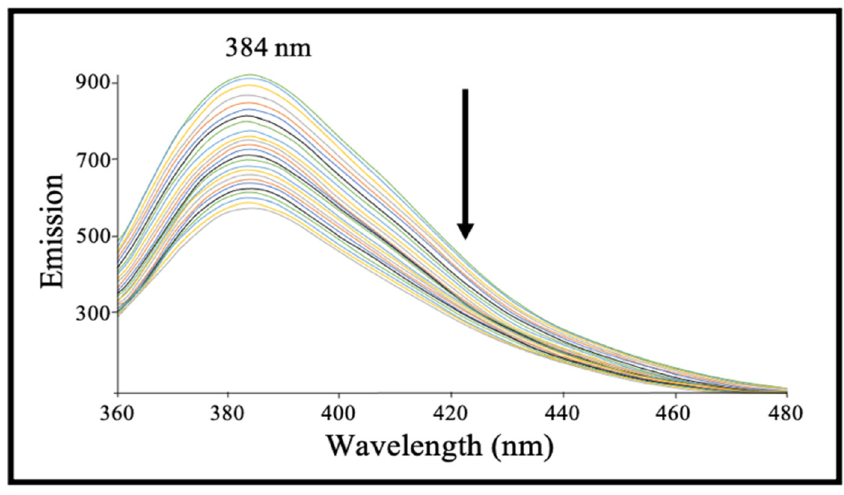
Figure 4. Fluorimetric titration spectra of [Cu(CQ)(PPh 3 ) 2 ]NO 3 with CT-DNA. [Complex] = 2.24 × 10 − 6 M, [DNA] = 0–276 µM. The interaction between the Cu(I)-CQ complexes and DNA were further elucidated by hydrodynamics studies. The viscosity measurement is considered as a very efficient method to determine the binding mode of copper complexes to DNA (i.e., intercalation or non-intercalation), because of its sensitivity to the change in the length of the DNA double helix. The relative viscosity of CT-DNA increased in the presence of complex 1 and 2 , and also in the CQ free ligand (Figure 5). This suggests the lengthening of the double helix as the DNA base pairs intercalate the copper complexes. This finding is similar to that reported for other metal-CQ complexes and for ethidium bromide, which is a classical intercalator [38]. Thus, this supports the idea that complex 1 and 2 can act as DNA intercalator.